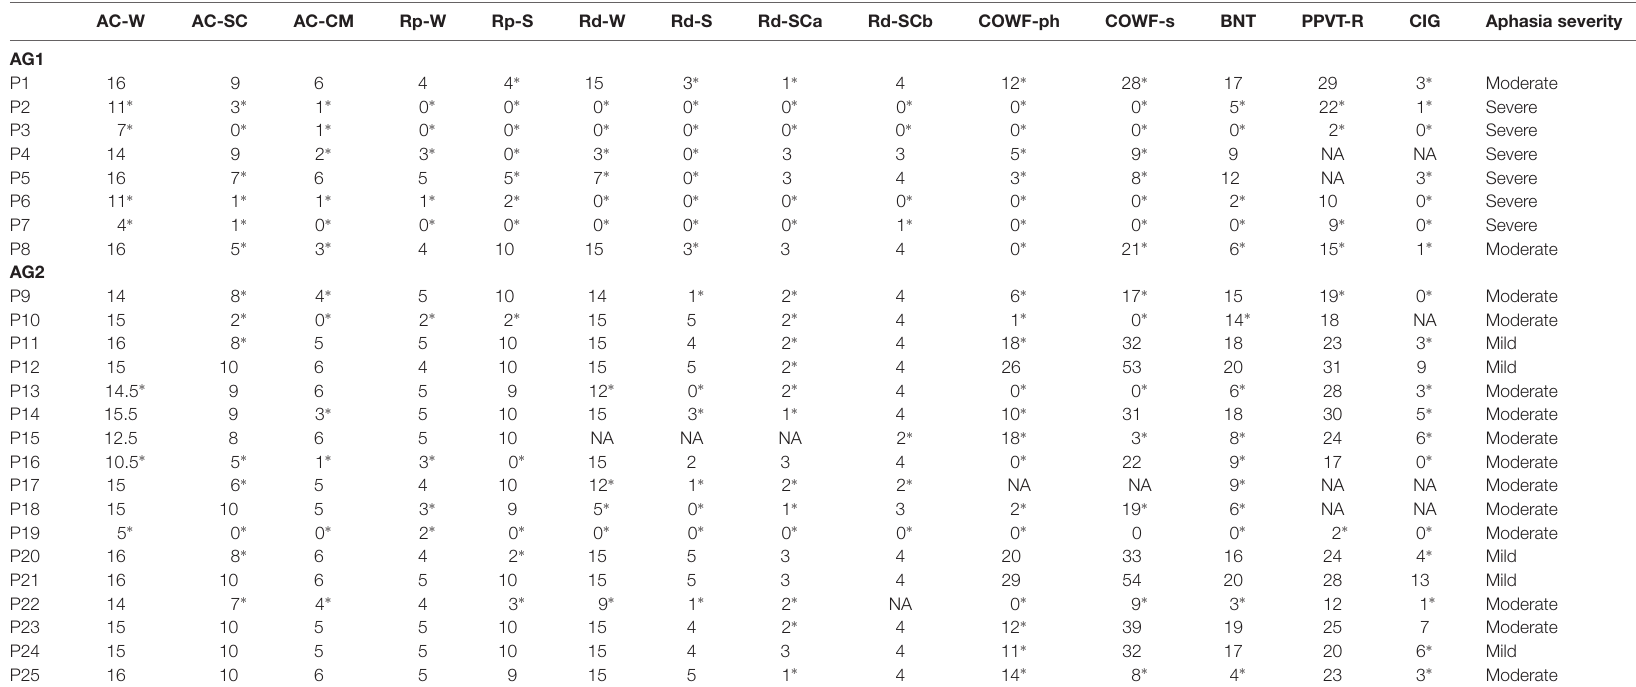
TABLE 4 | Individual scores of patients’ neuropsychological